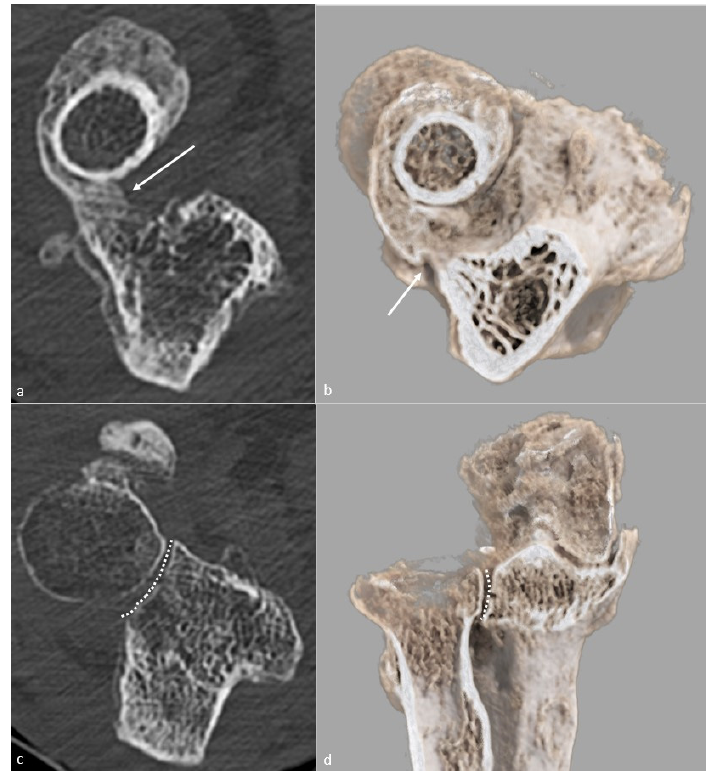
Figure 2. Proximal radioulnar synostosis . Proximal radioulnar synostosis (white arrow), leading to complete loss of forearm rotation in the same patient than in Figure 1, is shown on ( a ) an axial CT-scan view and ( b ) a global illumination 3D reformat. Note that the proximal radioulnar joint space (dotted line) can be considered normal and is shown ( c ) on an axial CT-scan view and ( d ) a global illumination 3D reformat.